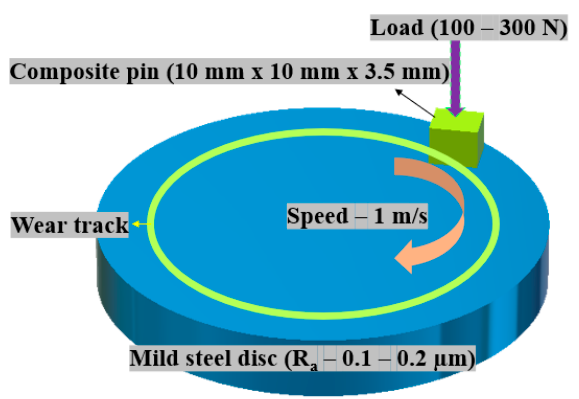
Figure 3. Pin-on-disc configuration used for tribo-evaluation.